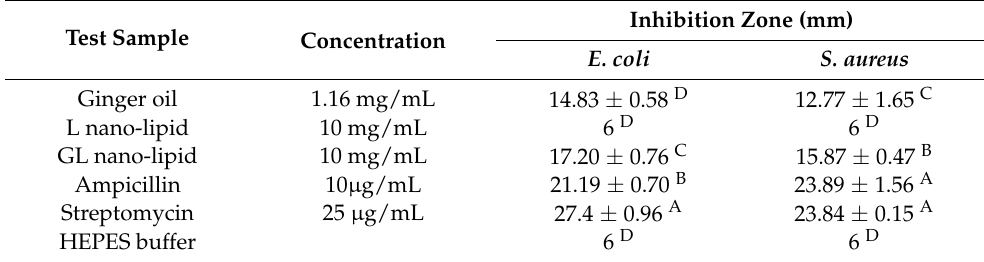
Table 1. Disc diffusion assay of GL nano-lipids against some pathogenic